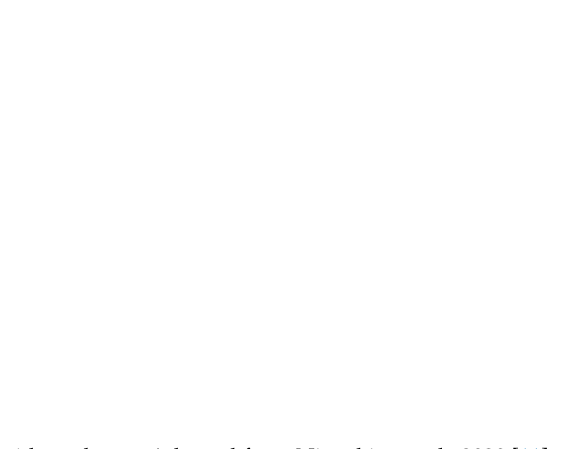
Figure 1. Nitrate–nitrite–nitric oxide pathway. Adapted from Niayakiru et al., 2020